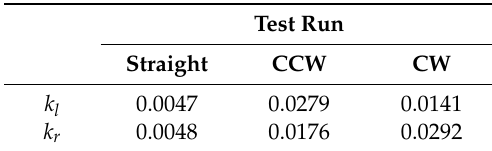
Table 1. Estimation results for 𝑘 𝑙 and 𝑘 𝑟 (m/m).